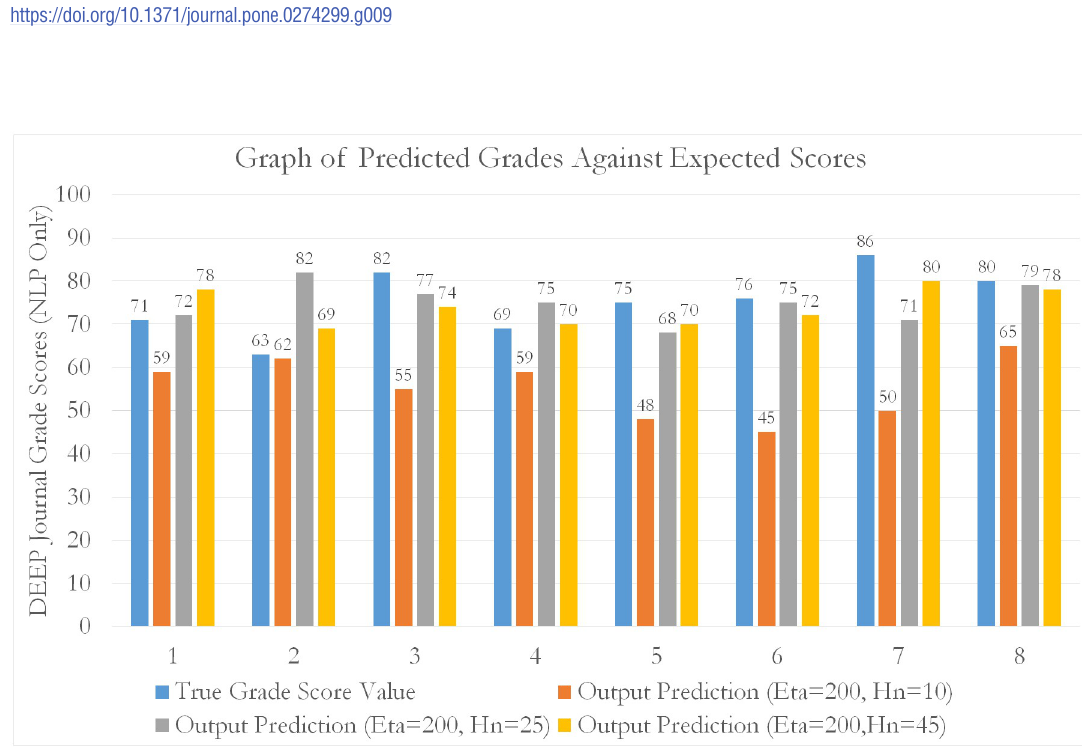
PLOS ONE | https://doi.org/10.1371/journal.pone.0274299 January 12, 2023 17 /